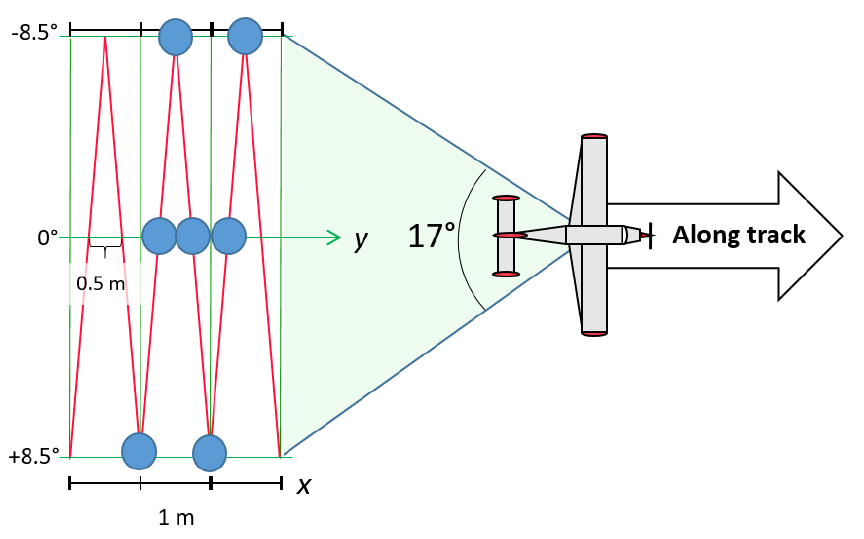
Figure 5. (x, y) plane of the scan-line geometry giving an along-track row spacing of 0.5 m at a nadir to 1 m on the side strip image with a minimum along-track point density of 1 m. At the nadir, the 0.50 m footprint allows placing two footprints in a pixel in the along-track direction. However, at the edges, the PRF allows obtaining at least one footprint in the middle of a